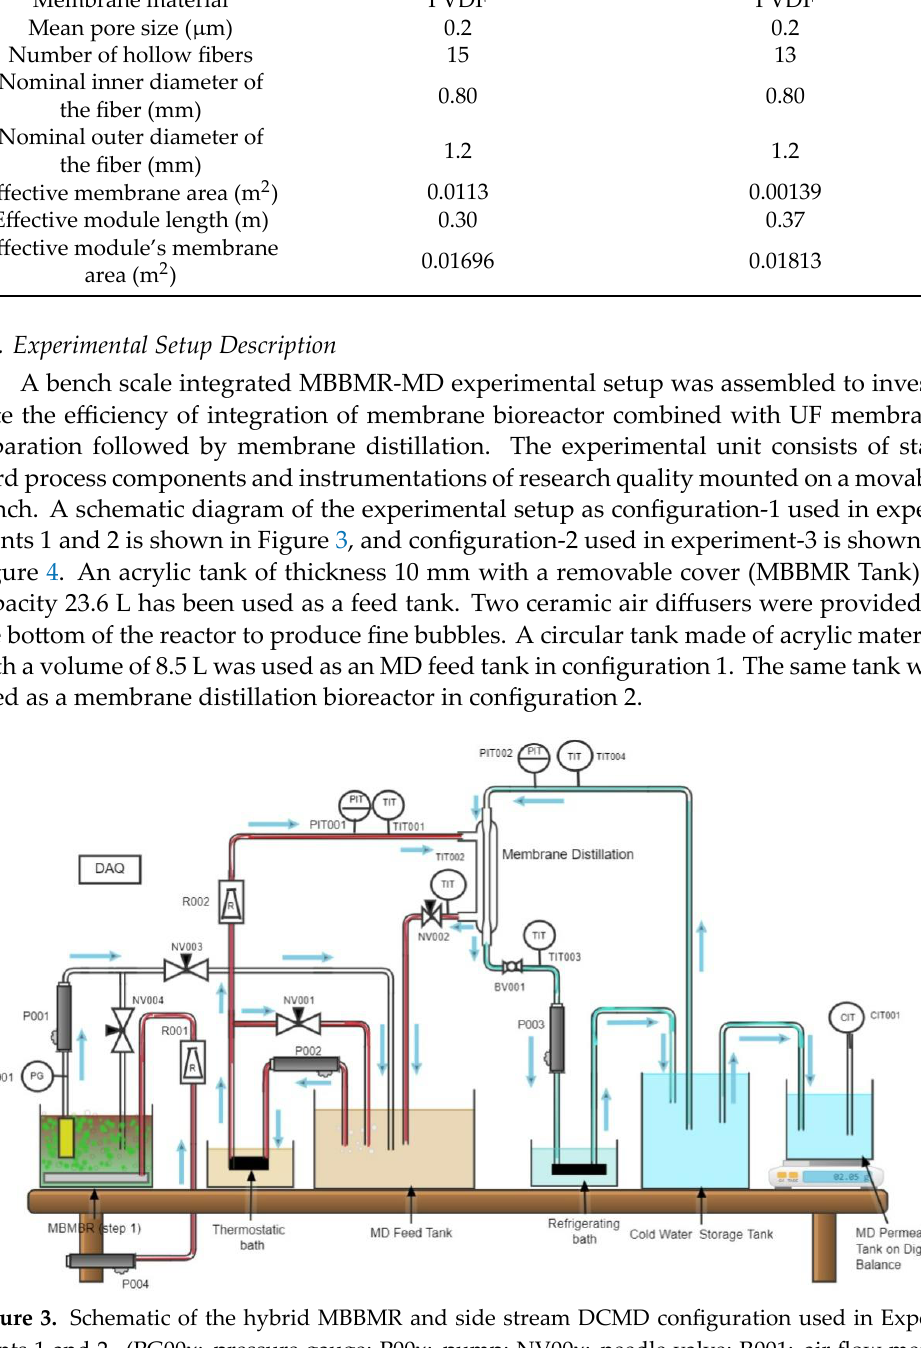
Figure 4. Schematic of the hybrid submerged MDBR configuration 2 used in Experiment 3. (PG00x: pressure gauge; P00x: pump; NV00x: needle valve; R001: air flow meter, R002: water flow meter; PIT00x: pressure transducer; TIT00x:. thermocouples; CIT001: conductivity transmitter. DAQ: data acquisition).